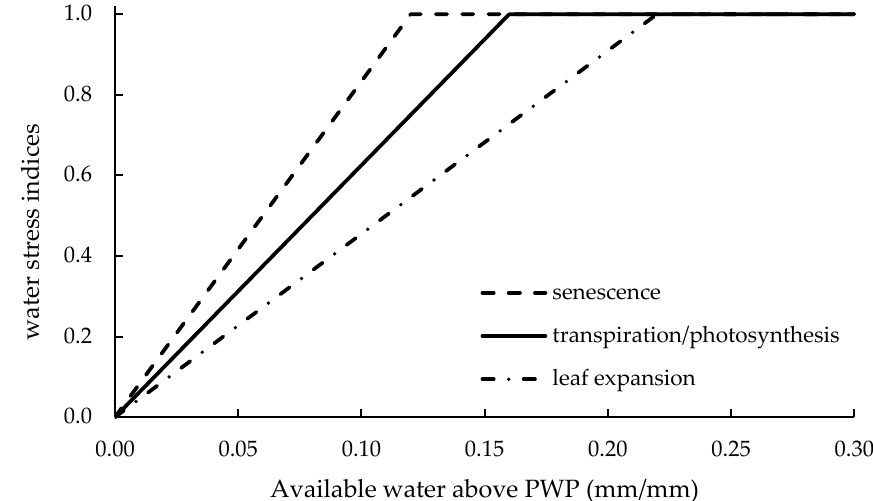
Figure 5. WS coefficients as a function of absolute available soil water content (above plant wilting point (PWP)) of the root zone in STICS (redrawn from Brisson et al. [113]).